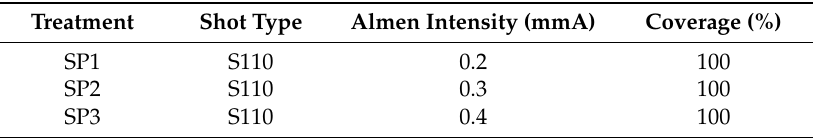
Table 3. Shot peening (SP) parameters adopted for treating fatigue specimens.